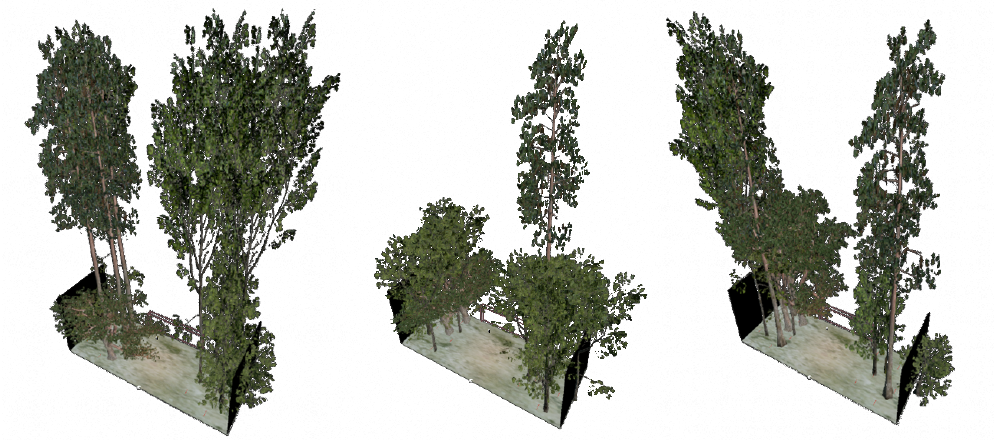
Figure 5. Tiles populated with procedurally placed obstacles. Note that the tree branches in the central region of the tiles are implemented as small rotated trees.